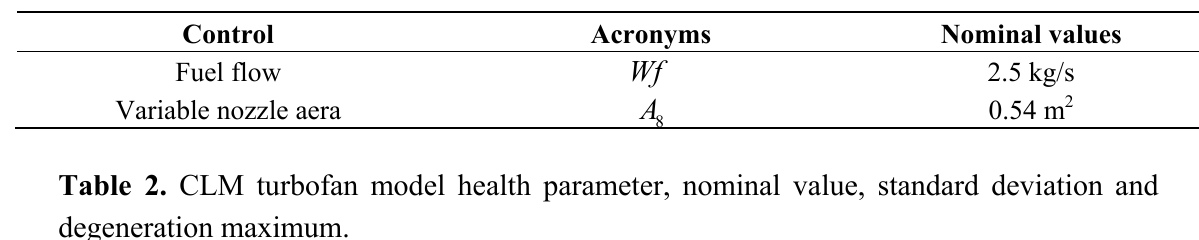
Table 1. CLM turbofan model controls and nominal values.